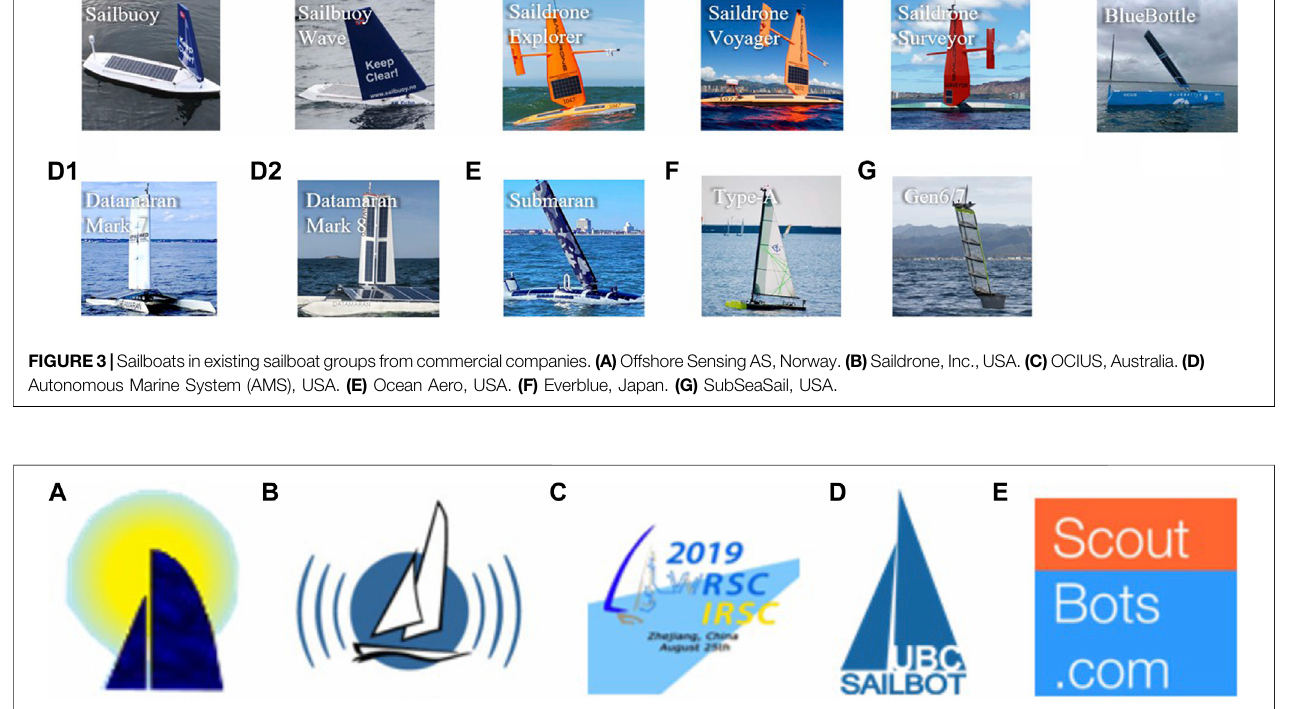
FIGURE 4 | Different sailboat groups in society and organization. (A) Microtransat Challenge, 2006 – present. (B) International Robotic Sailing Regatta (IRSR) SailBot, 2006 – present. (C) World Robotic Sailing Championship (WRSC) and International Robotic Sailing Conference (IRSC), 2008 – present (The logo is chosen from the 2019 activity). (D) Scoutbot